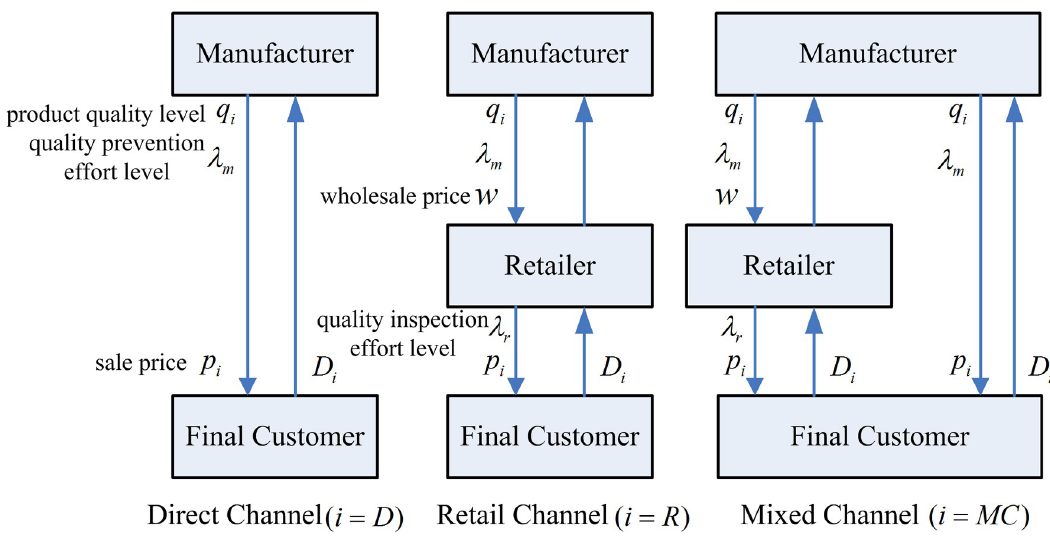
Fig 1. Three types of distribution channels decision